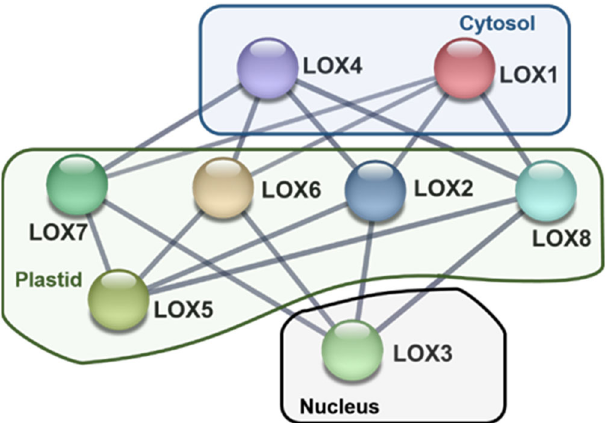
Figure 6. Predicted computational protein–protein interaction (PPIs) network among the eight pepper LOX isozymes encoded by the LOX genes (CaLOX1—CaLOX8) identified in the transcriptome of California-type sweet pepper fruits. The analysis was performed using STRING v11.0 with minimum required interaction score set in “medium confidence” (0.400). The proteins were assigned to either cytosol, plastids or nucleus as predicted by WoLF PSORT tools.